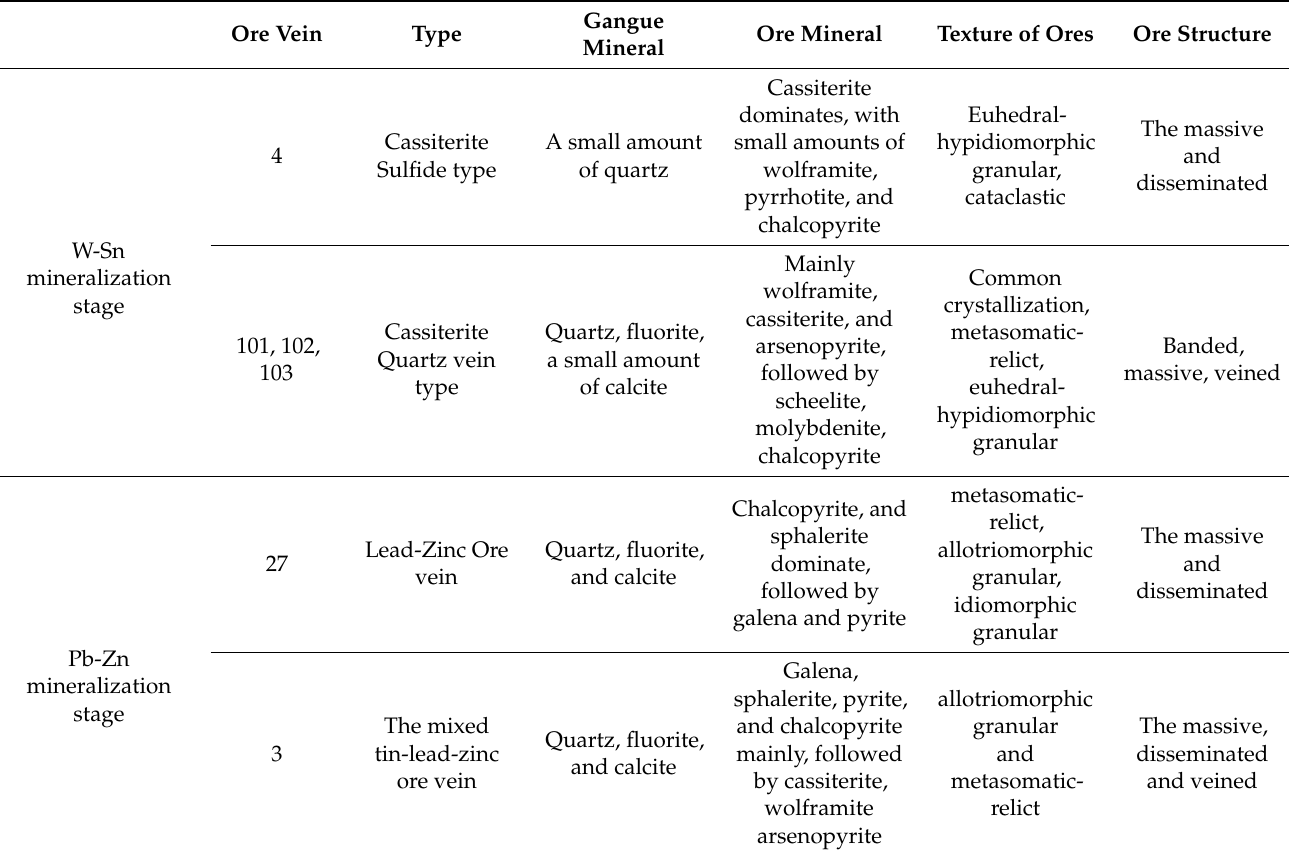
Table 1. Ore vein type and mineral assemblage of the Hongqiling W-Sn-Pb-Zn deposit. Gangue Ore Vein Type Ore Mineral Texture of Ores Ore Mineral